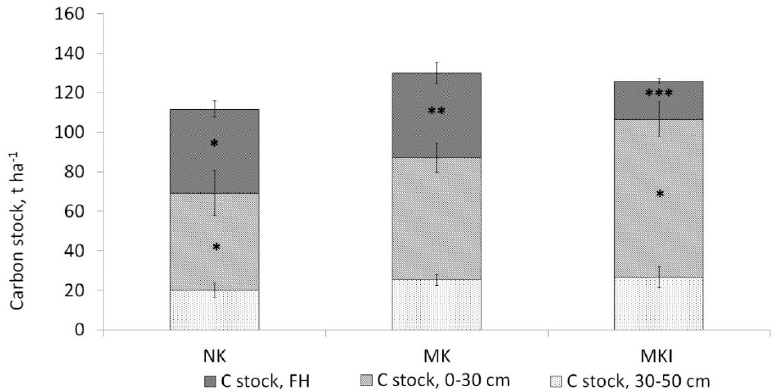
Figure 4. Soil carbon stocks in forests of three areas. NK—northern taiga, Republic of Karelia ( n = 34), MK—middle taiga, Republic of Karelia ( n = 35), MKI—middle taiga, the Karelian Isthmus, Leningrad